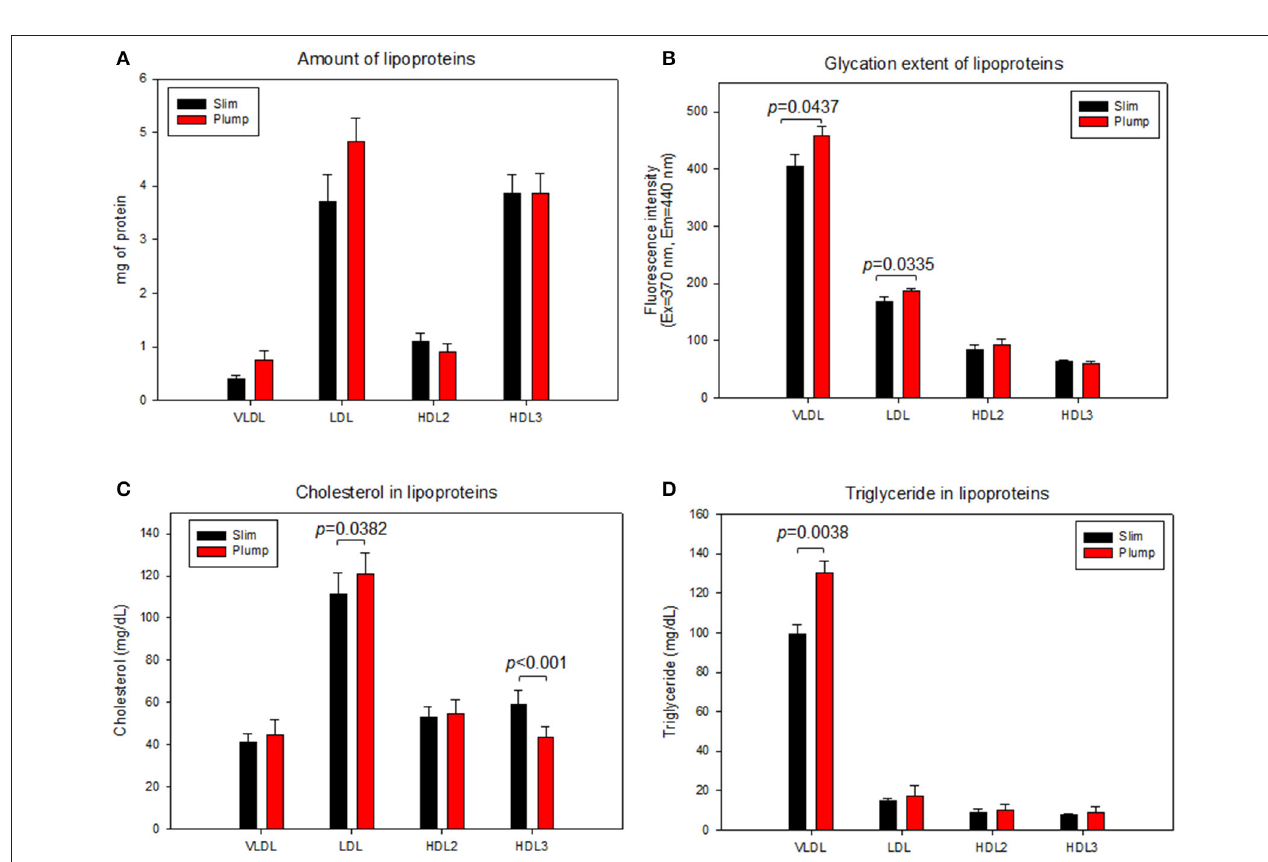
more glycated ( Figure 6B ) and oxidized ( Figure 7 ), as modified LDL was more phagocytosed by macrophages to accelerate foam cell